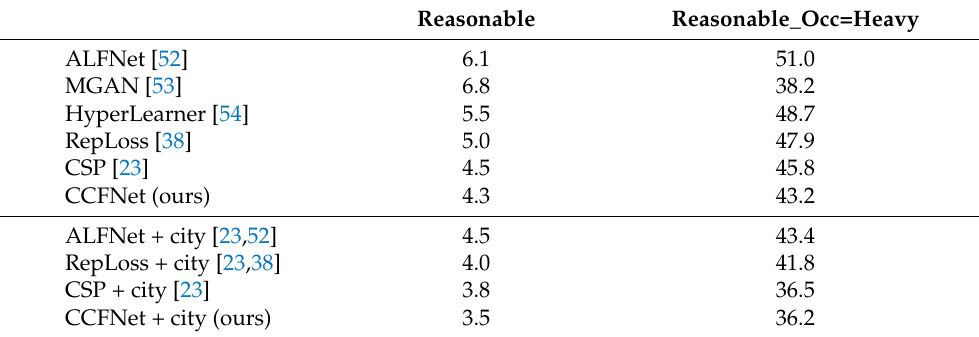
Table 6. The results of various models on the Caltech